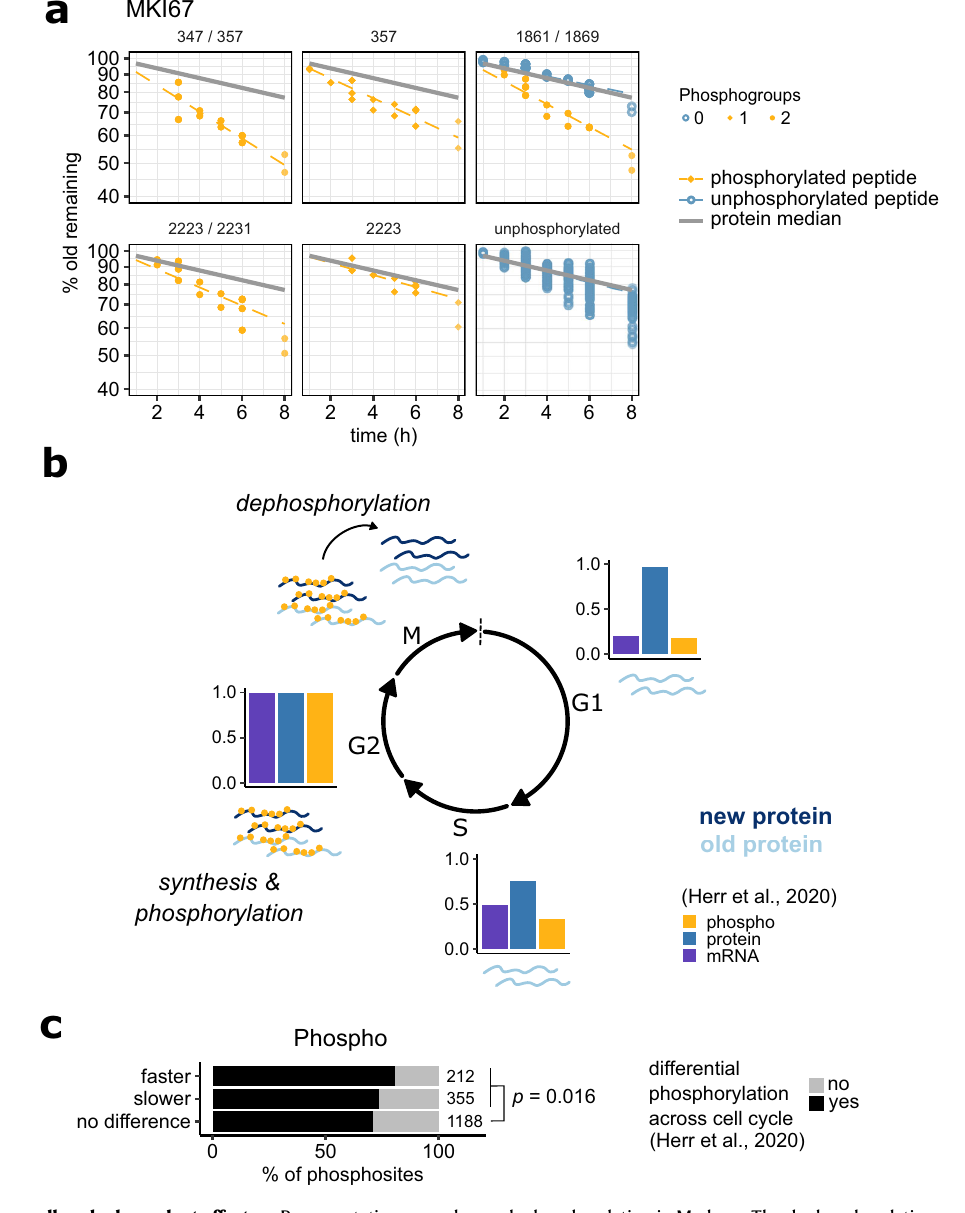
dephosphorylation in M phase. The dephosphorylation event suggested by the fasterclearancemeasuredbyPPToP( a )explainspreviousreportsofMKI67 ’ srolein condensationofchromosomesduringMphase 24 . c Hitsfromthephosphofraction are enriched for peptides exhibiting cell cycle-dependent changes in phosphor- ylationorabundance 22 .Fisher ’ sexacttest,two-sided.Sourcedataareprovidedasa Source data fi